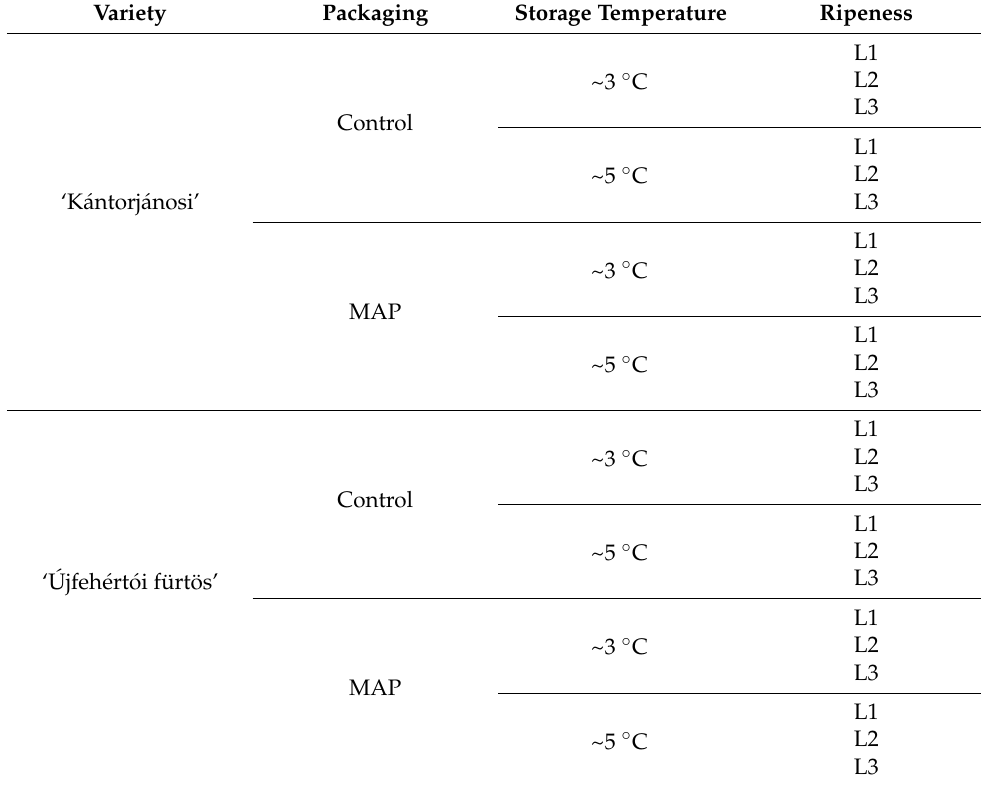
Table 2. Sample groups used in Experiment